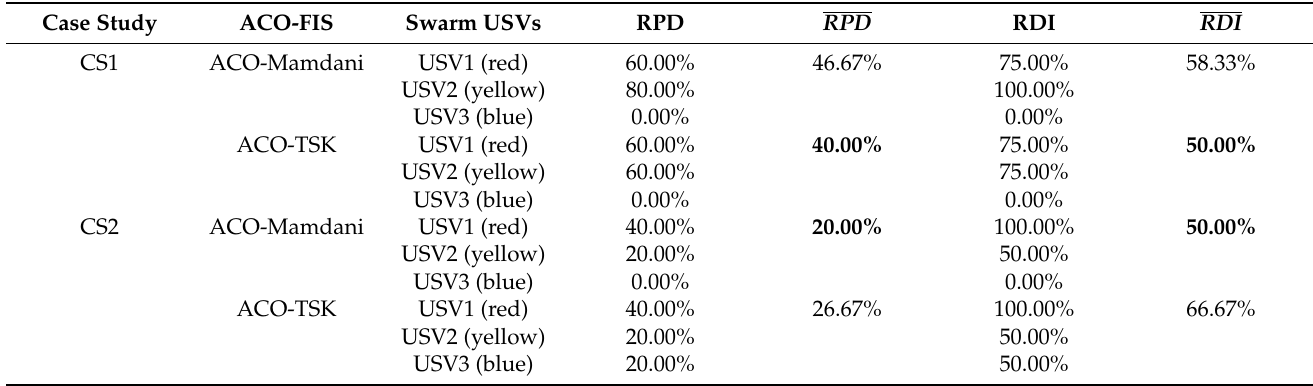
Table 6. Evaluation results of mean relative percentage deviation (RPD) and mean relative deviation index (RDI) for brute turns. The best solutions are denoted in bold.